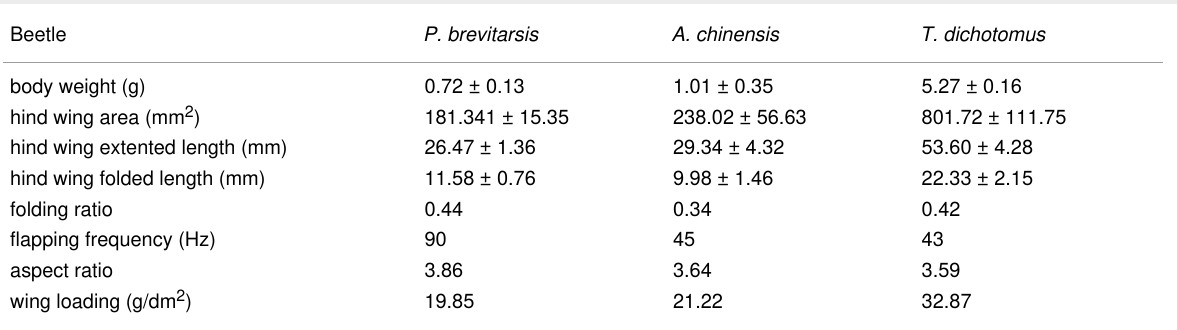
Table 1: Beetle hind wing parameters.